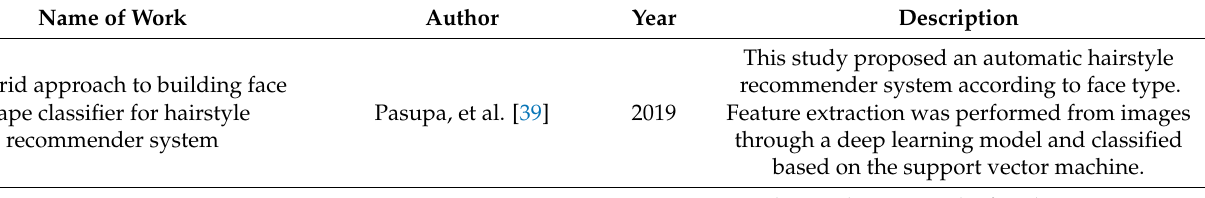
Table 1. Summary of related